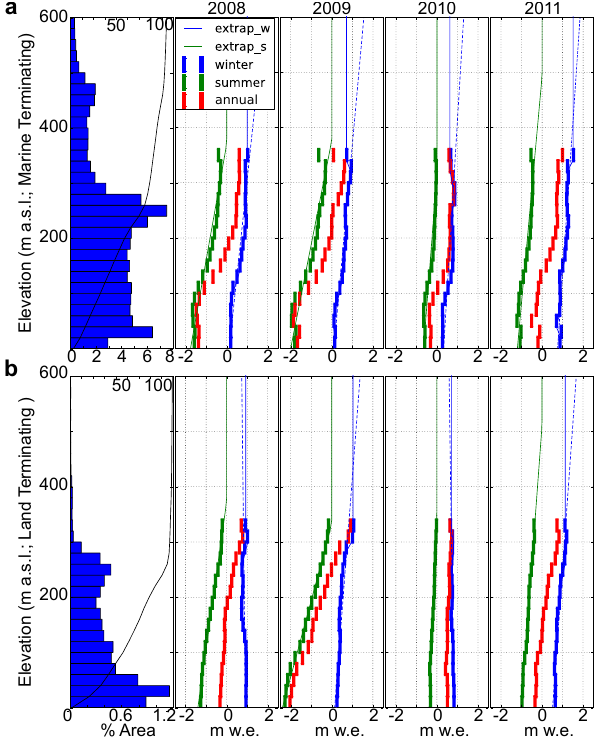
Figure 4. Winter, summer and annual mass-balance profiles from Johnsons (a) and Hurd glaciers (b) for the mass-balance years 2007/2008 to 2010/2011 used to determine the surface mass bal- ance of the entire ice cap. The area–altitude distribution for the whole Livingston Island ice cap is shown for 20m elevation bands (blue bars) and cumulative (black line), for marine-terminating (a) and land-terminating (b) basins. Thinner lines (extrap_w and ex- trap_s) show the extrapolation of the profiles beyond the elevations where observations are available. For the winter balance, two ap- proaches (solid and dashed blue line) were compared. The profiles are based on measurements taken in late November/early December (winter balance) and late February/early March (summer balance). The former measurements coincide well with the start of the melt- ing season, but for the summer balances corrections were applied to account for continued melting after the measurement dates.